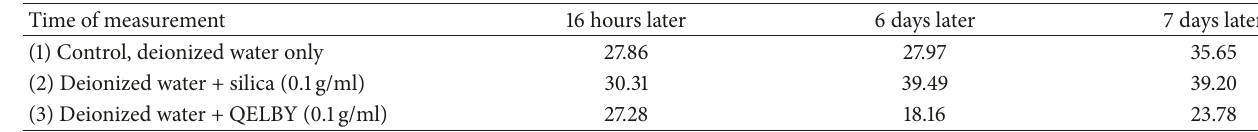
Table 1: Average number of ultra-weak photon emissions per one second . Measurements were taken for eight minutes, from bean sprout stems stored in deionized water only, water mixed with the silica powder, and water mixed with the QELBY ceramic powder. Time of measurement 16 hours